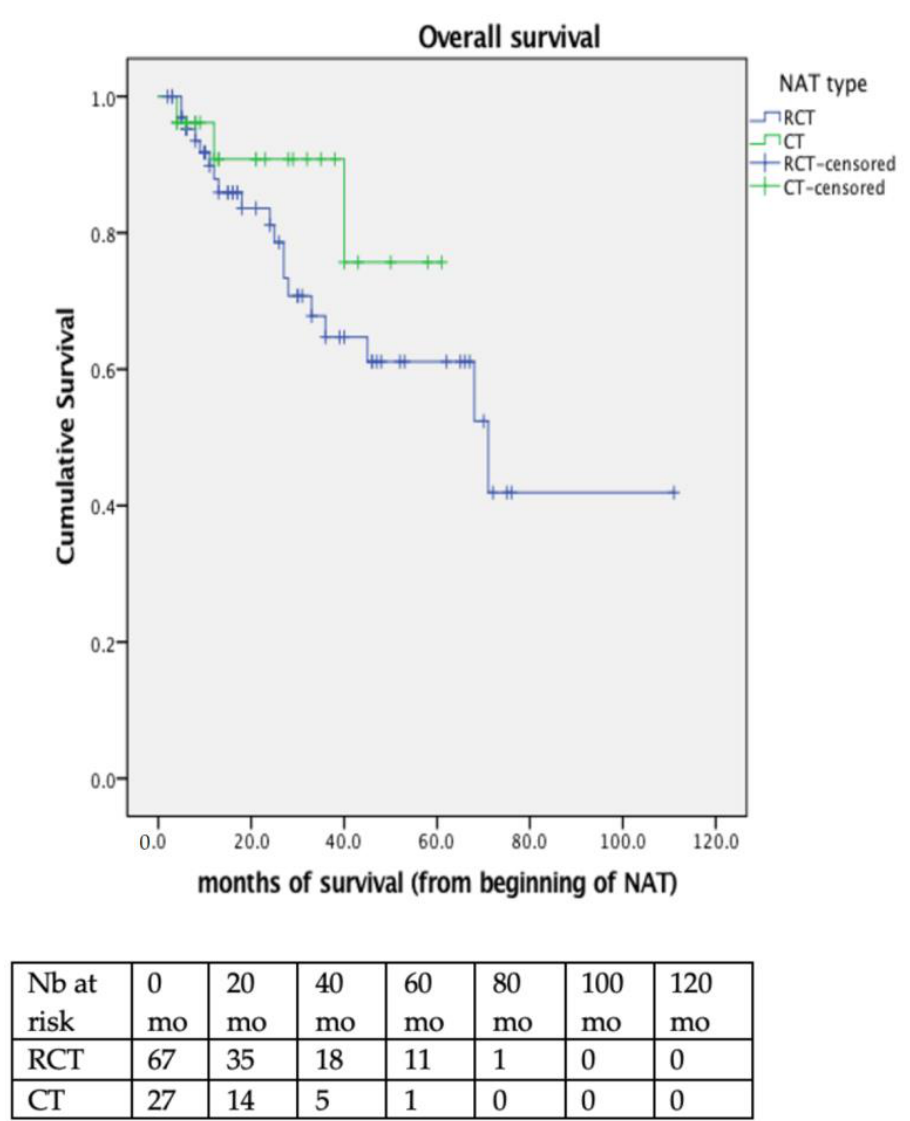
Figure 2. Overall survival (OS) for all patients, according to their treatment group. RCT patients had a median OS of 71 months (95%CI 37.5–104.4) whereas median OS was not reached in the CT group. 3-year OS was 78.6% in RCT and 75.7% in CT patients ( p = 0.259). NAT = neoadjuvant treatment; RCT = radio-chemotherapy; CT =